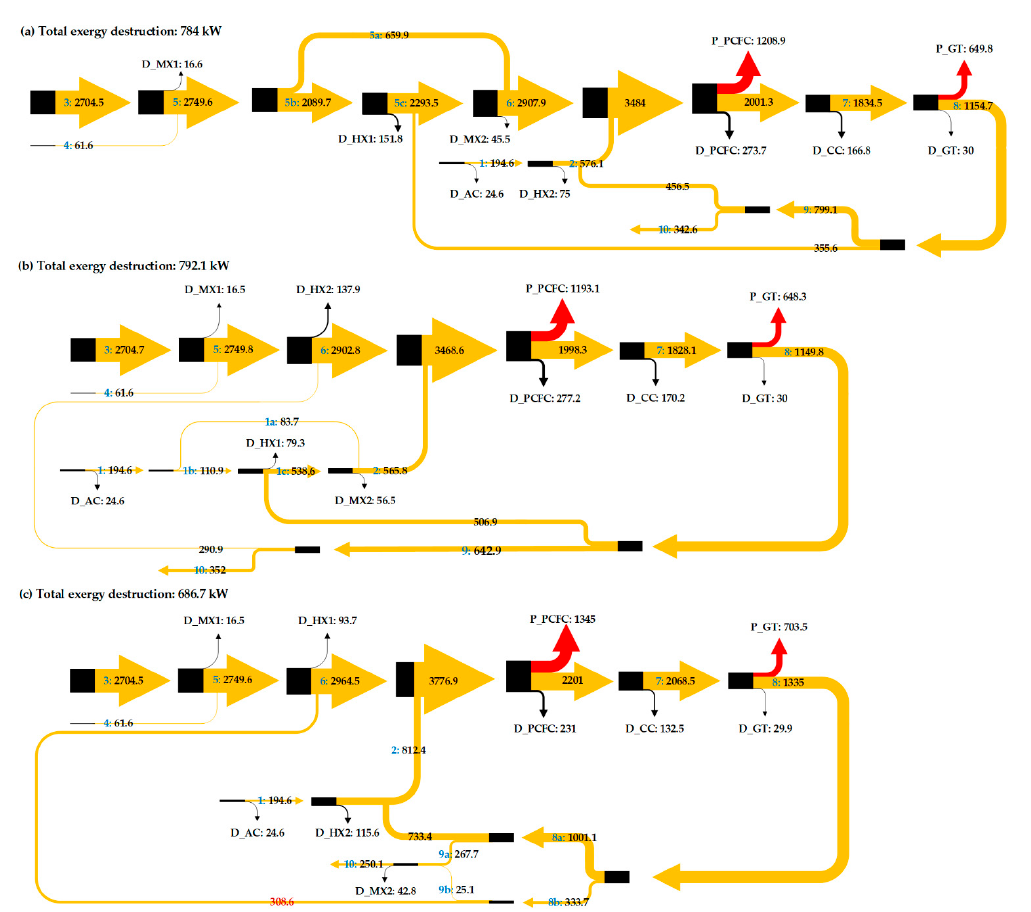
Figure 5. Sankey diagram to show the exergy flow through the proposed IR‑PCFC/GT hybrid system. Table 3. Stream properties (temperature, physical exergy flow, chemical exergy flow) in case 1, case 2, and case